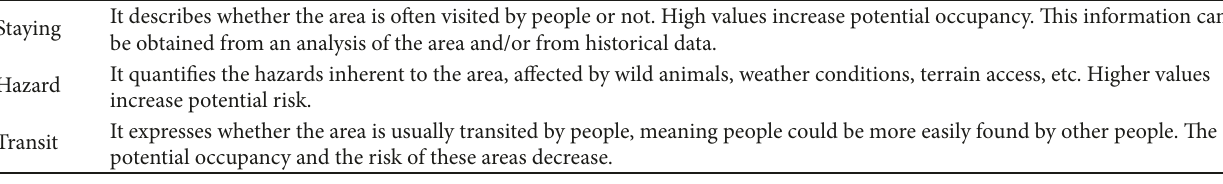
Table 1: Terrain factor inputs.